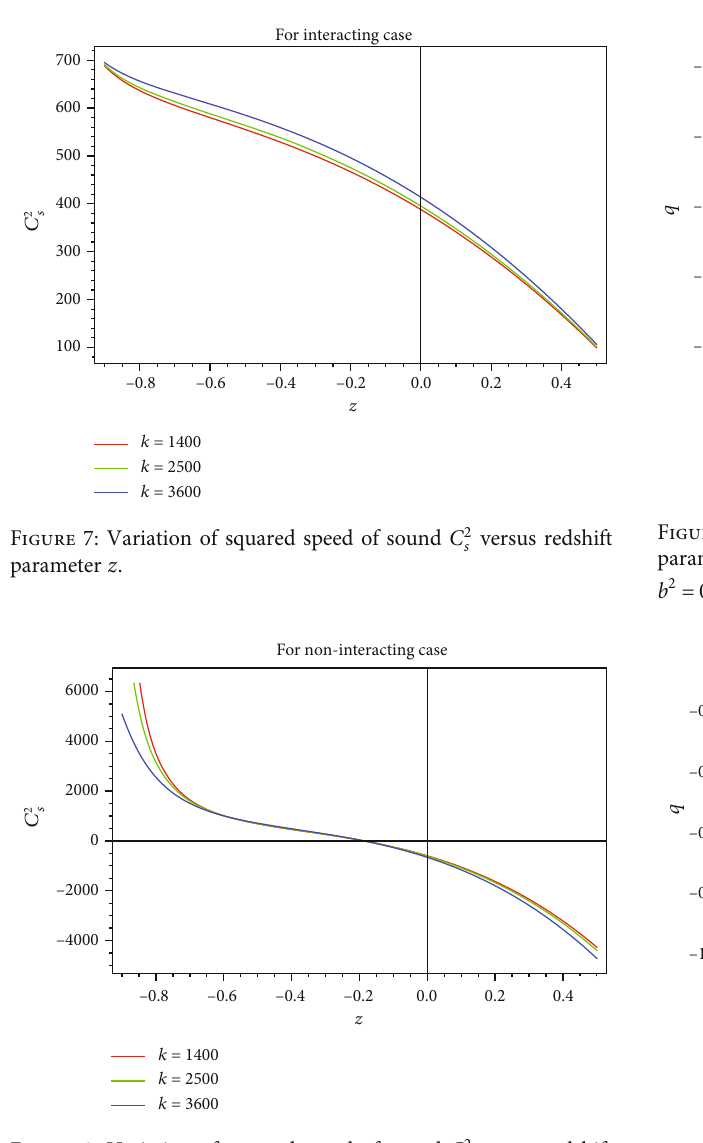
Figure 10: Graph of q against z .